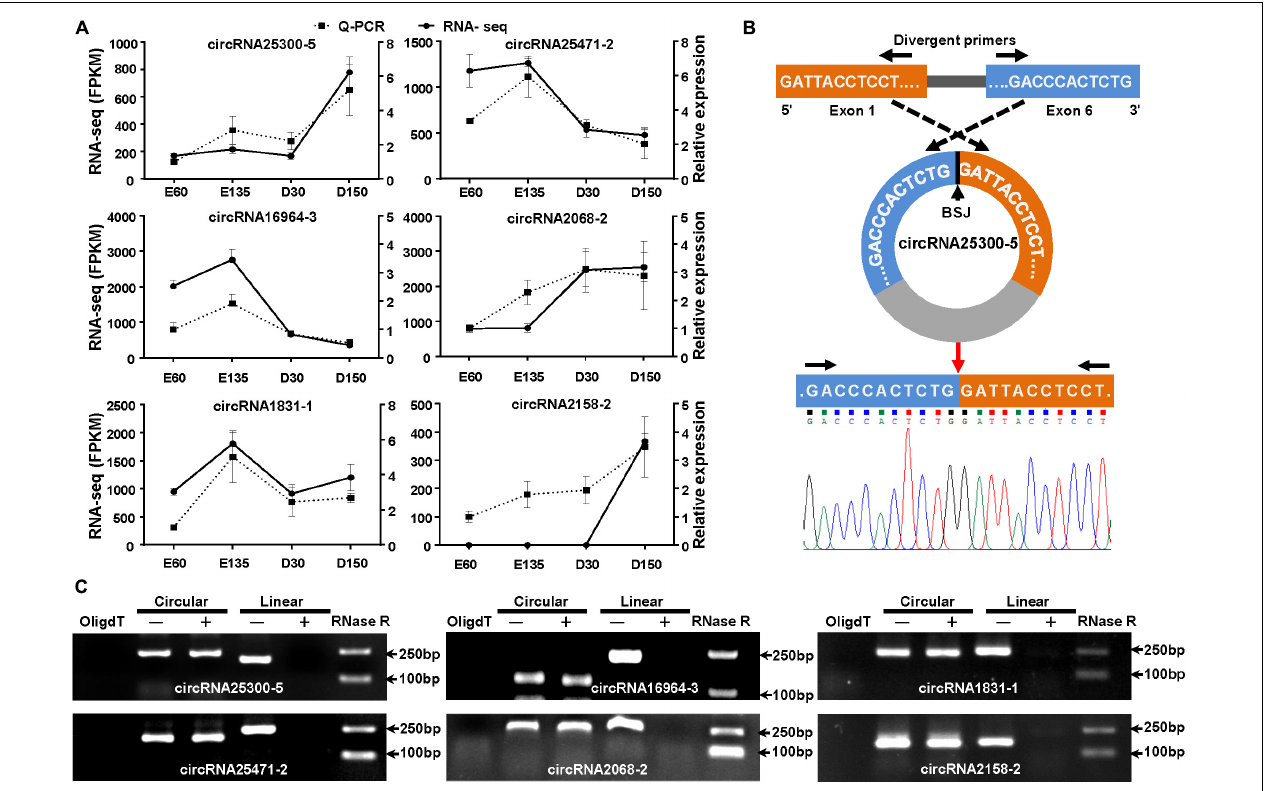
FIGURE 6 | Validation of DECs in goat rumens in the fetal and prepubertal periods. (A) Expression profiles of the six randomly selected circRNAs based on RNA-Seq and qPCR. (B) Schematic for back-splicing junction (BSJ) validation of circRNAs, represented by circ25300-5. The (BSJ) sequence was confirmed by Sanger sequencing. (C) RNase R assay for the circularity of the selected circRNAs by resistance to exonuclease digestion. OligdT shows the template cDNA for RT-PCR synthesized with the OligdT primer, while others were generated using random primers. +, indicates the samples were treated with